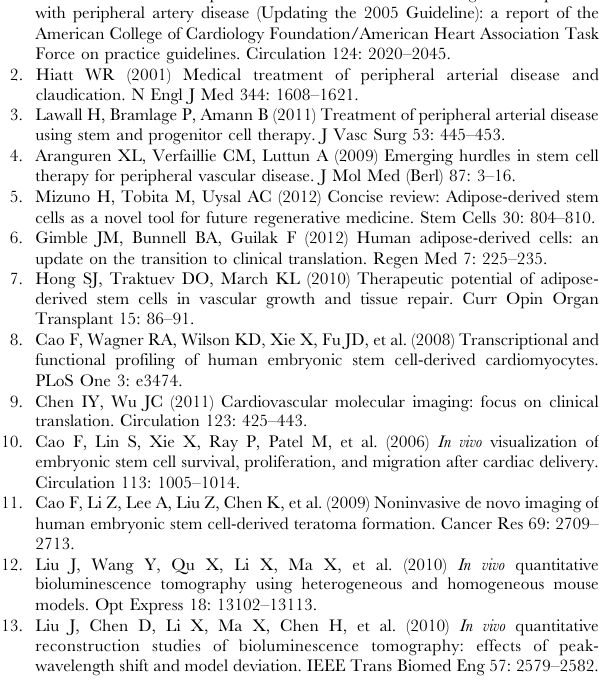
mADSCs Fluc + GFP + in vivo on post-transplant day 14. Methods S1 Document contains supplemental